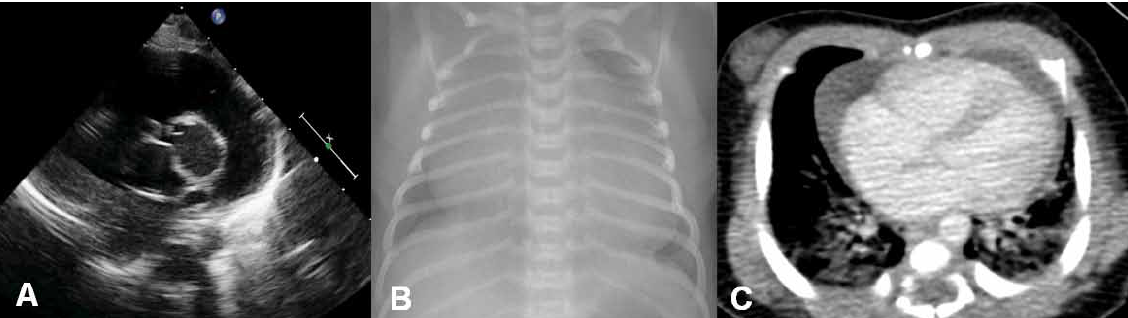
Figure 1. Initial echocardiography (A), chest radiograph (B), and computed tomography image (C) showing massive fluid accumulation within the